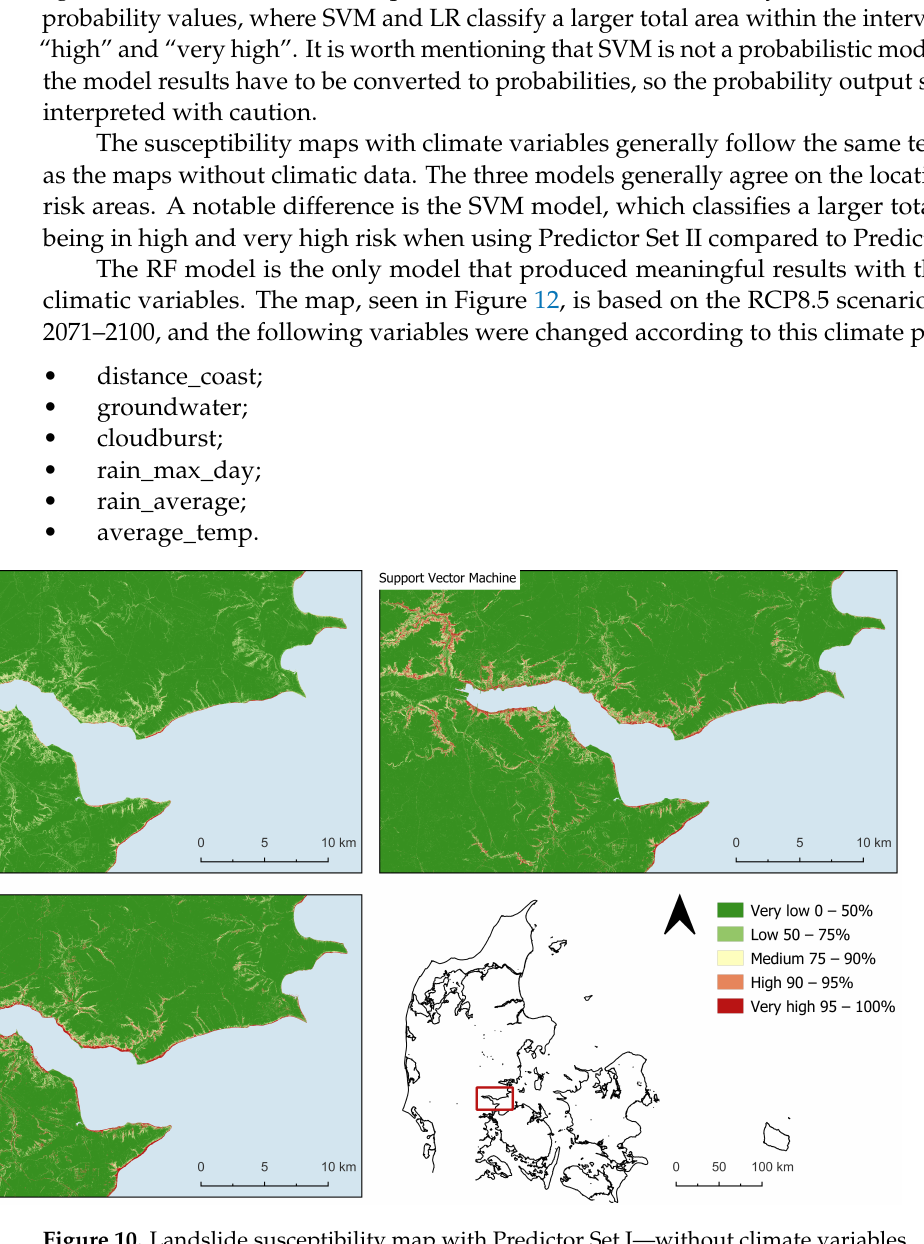
Figure 10. Landslide susceptibility map with Predictor Set I—without climate